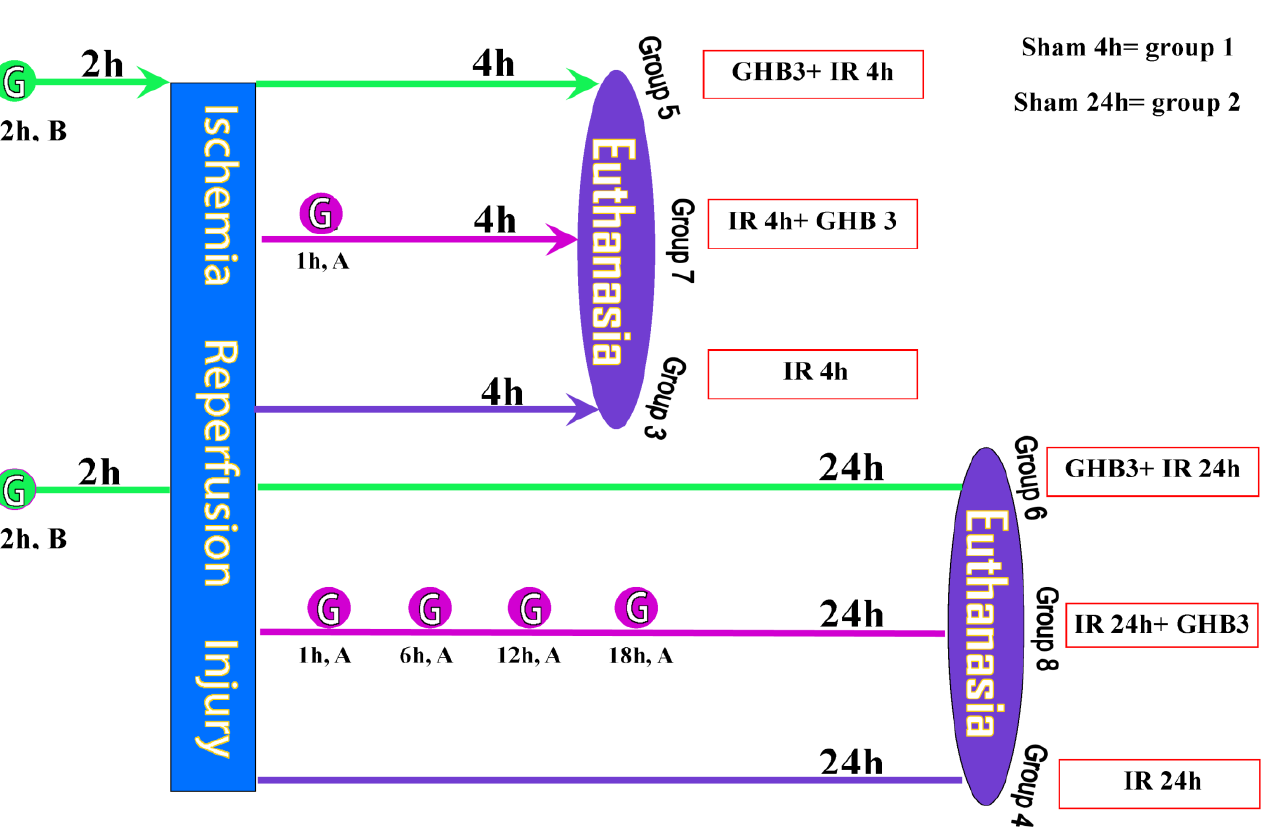
Figure 1. The schematic diagram of experimental